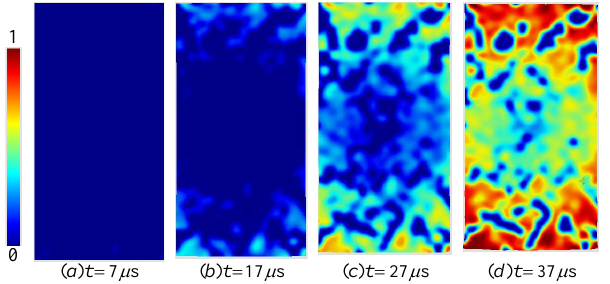
Figure 17. The evolution of damage field for the high amplitude load and cohesion realization with l c = 10 mm at times: ( a ) 8 µ s, ( b ) 18 µ s, ( c ) 28 µ s, and ( d ) 38 µ s. The results are shown on the deformed mesh with a magnification factor of 100.